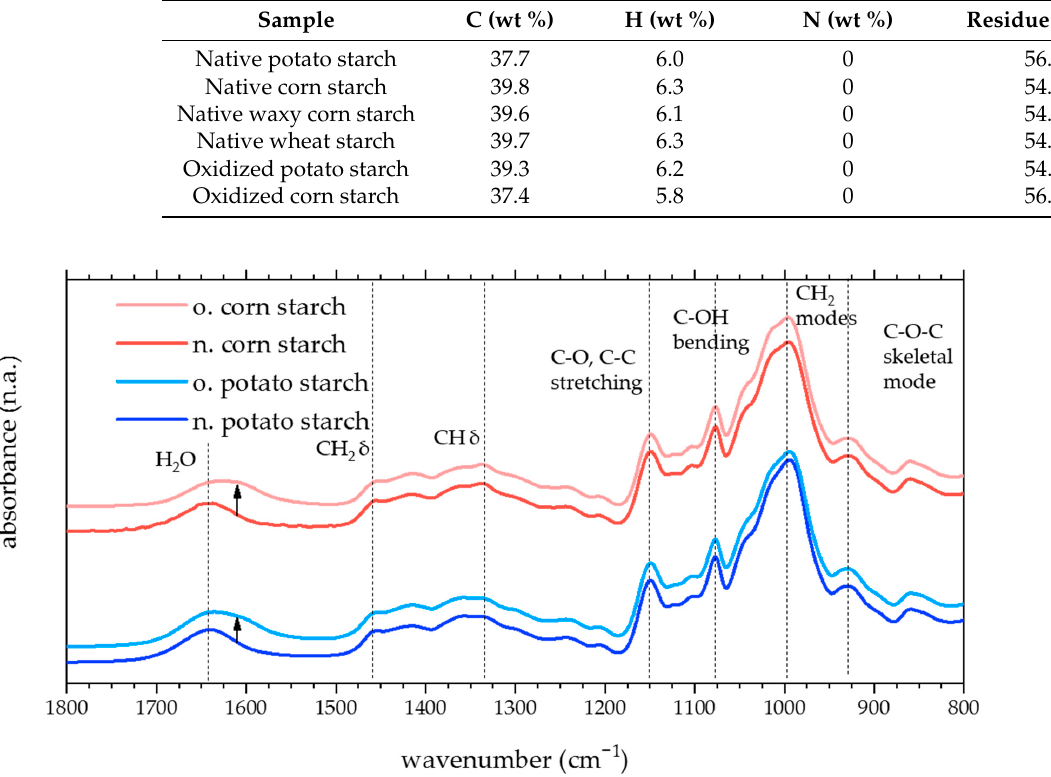
Figure 2. ATR-FTIR spectra comparison of oxidized and native corn as well as potato starches, C=O vibration mode is marked as arrow and other vibrations are marked as dashed line. Table 2. Calculated degree of branching (BD) (see Equation (1)) for the different starch samples and the values for the respective integrals used for calculation. The respective spectra are shown in Figure S1.